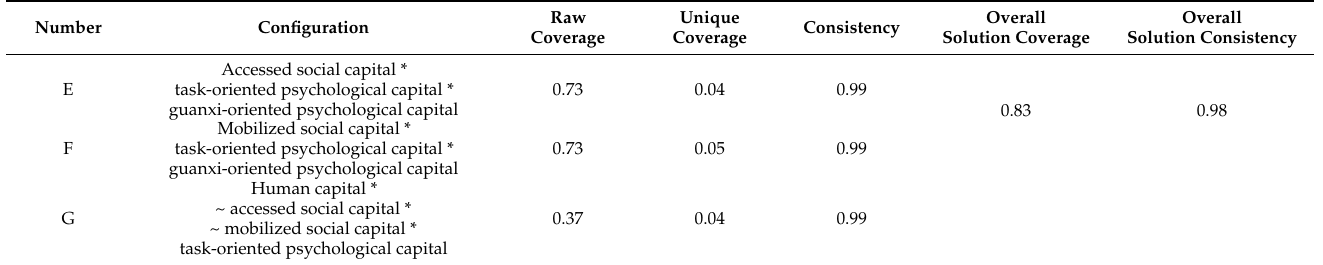
Table 3. Configurations for achieving high psychological